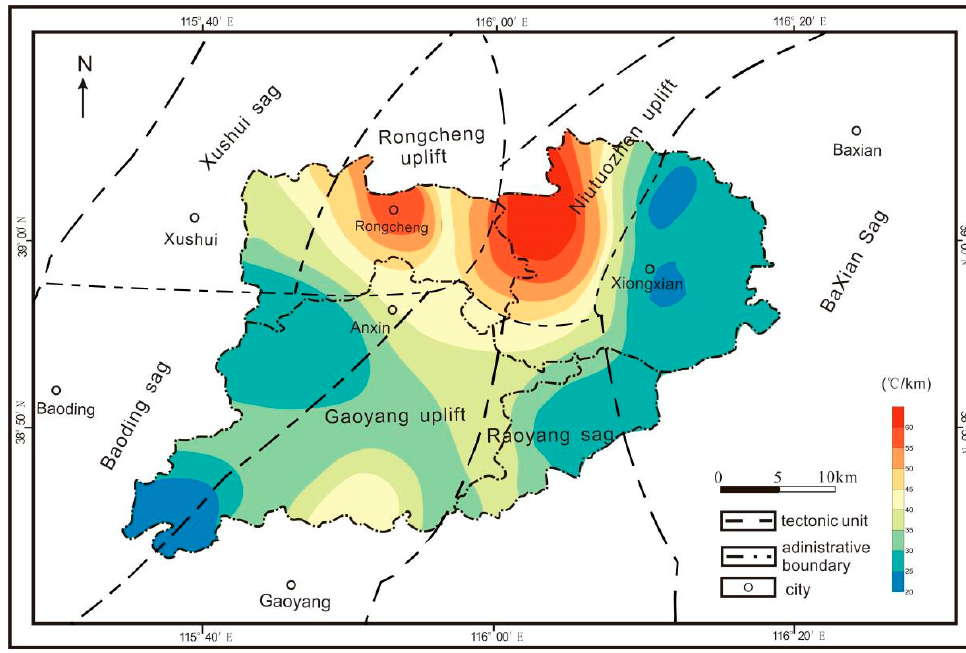
Figure 7. Planar graph of the geothermal gradient in the Xiong’an New Area.